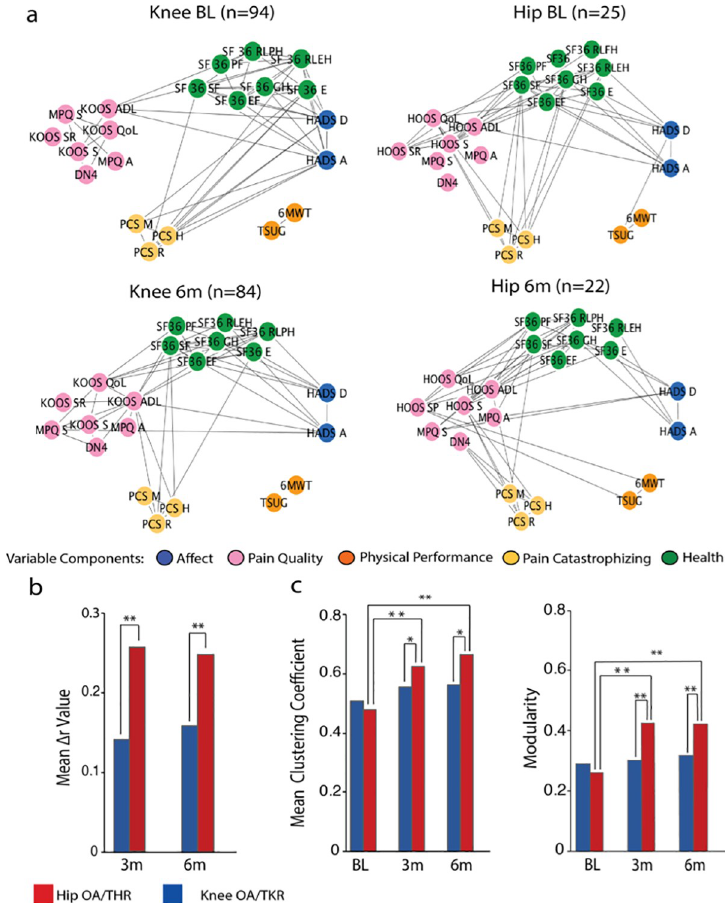
Fig 5. Network representation of OA pain characteristics. a) Network graphs depict interrelations between clinical and pain-related questionnaire subscale measures at baseline, and at 6 months post-surgery, for KOA and HOA patients. Network communities were derived from the PCA analysis. Links represent the top 25% correlations of each network. b) The bar graph displays mean change of global correlation coefficients (Pearson’s Δ r) for KOA and HOA, at 3- and 6-months post-surgery. Both groups had significant change in the overall interrelations between clinical and pain-related characteristics (KOA mean Δ r 3months: 0.14, t = 13.37, mean Δ r 6months: 0.16 t = 14.93, HOA mean Δ r 3months:0.28, t = 8.72, mean Δ r 6months:0.26 t = 9.23, p < 0.001). The extent of change remained stable from 3 to 6 months post-surgery and was substantially higher in the HOA group at 3 months (t = 4.62, p < 0.001) and 6 months (t = 3.44, p < 0.001). c) Graph theory-based modularity and mean clustering coefficients for correlation networks at baseline, 3 and 6 months. The HOA networks shows significant topological reorganization 3 months (mcc: t = -8.19, modularity: t = -9.22, p < 0.001) and 6 months after surgery (mcc, t = -10.62, modularity, t = -9.02, p < 0.001), while KOA remains stable. BL, baseline; 3m, 3 months; 6m, 6 months; Statistical risk probability was computed under 10.000 times repeated random resampling. �� p < 0.001, � p <